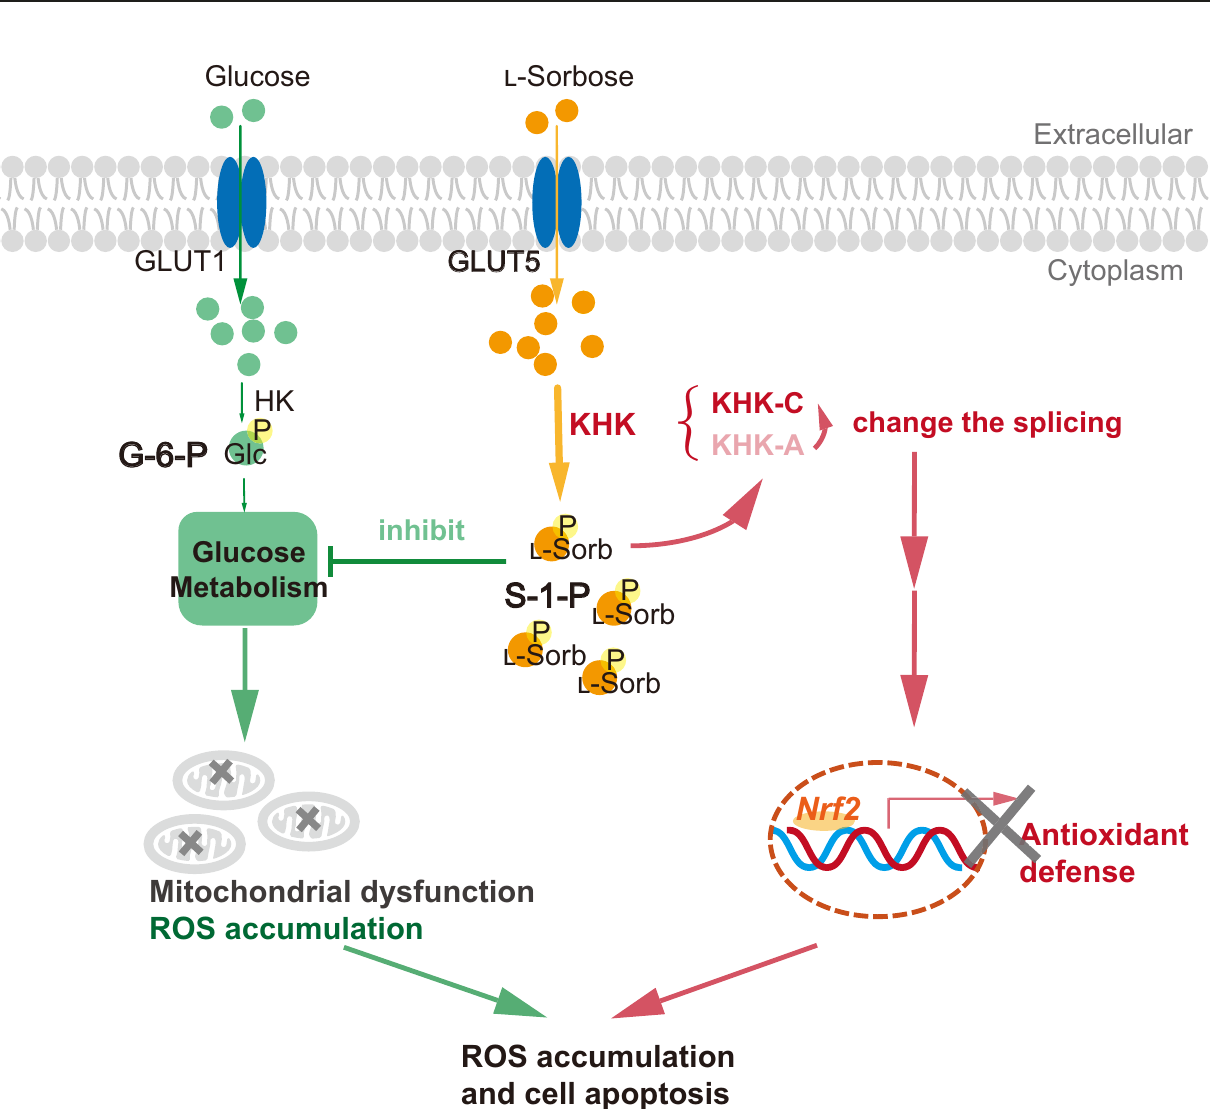
Fig. 8 L -Sorbose treatment downregulates the expression of KHK-A and inactivates Nrf2-regulated antioxidant defense. a The mRNA levels of KHK-A and KHK-C in cells with or without (ctrl) 25 mM L -sorbose treatment for 24 h. n = 3. b Left panels: Western blotting was performed to analyze KHK-A and KHK-C expression in cells after L -sorbose treatment for 24 h. Right panels: Relative intensities of KHK-A and KHK-C. The intensity of KHK-A and KHK-C normalized to β -tubulin detected in cells without L -sorbose treatment were de fi ned as 1. n = 3. c Left panels: Western blot of Nrf2 in the nuclear fractions of Huh7, HepG2 and WRL68 cells treated with or without (ctrl) 25 mM L -sorbose for 24 h. Right panels: Relative intensities of Nrf2. The intensity of Nrf2 normalized to PCNA detected in cells without L -sorbose treatment was de fi ned as 1. n = 3. d Levels of mRNA expression of Nrf2-regulated antioxidative genes in Huh7 and HepG2 cells treated with or without (ctrl) 25 mM L -sorbose for 24 h. The mRNA level detected in cells without L -sorbose treatment was de fi ned as 1, and relative mRNA levels detected in L -sorbose-treated cells are shown. n = 3. Data are presented as the mean ± s.d. and were analyzed by